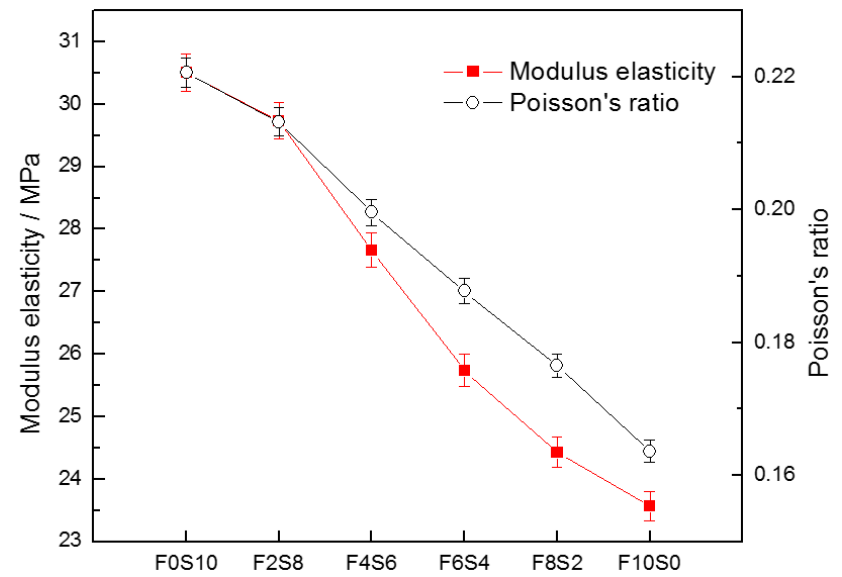
Figure 7. Modulus elasticity and Poisson’s ratio of the alkali-activated concretes.